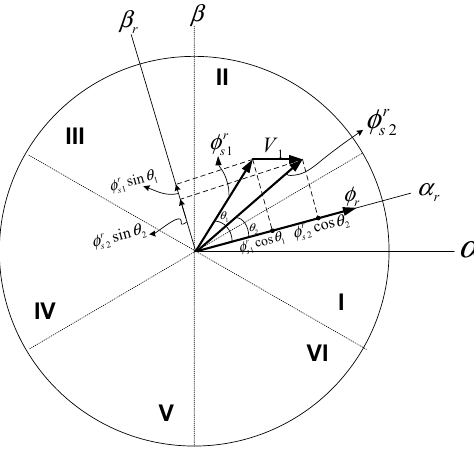
Figure 9. Effect of vector 1 V on active and reactive power changes.